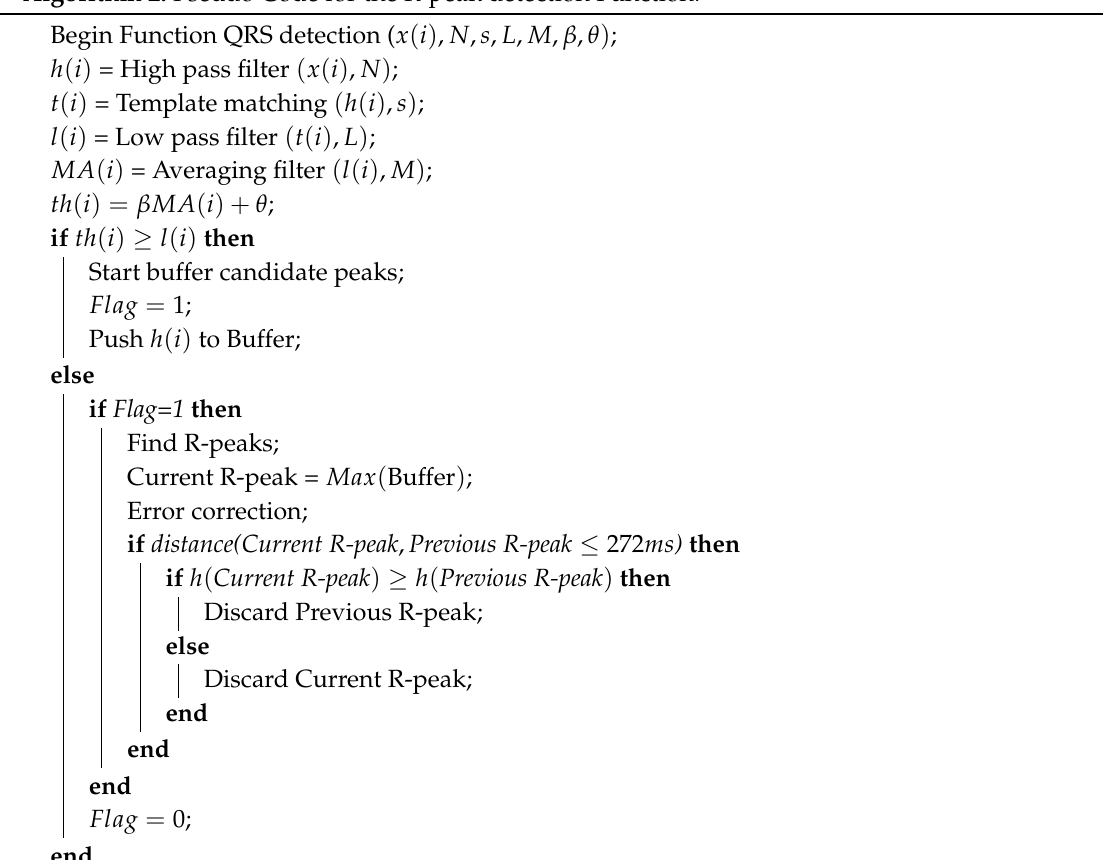
Figure 4. Multiple detected points in one QRS complex. Algorithm 2: Pseudo Code for the R-peak detection